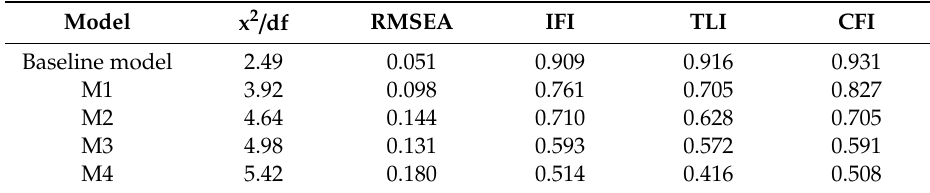
Table 2. Comparison of measurement